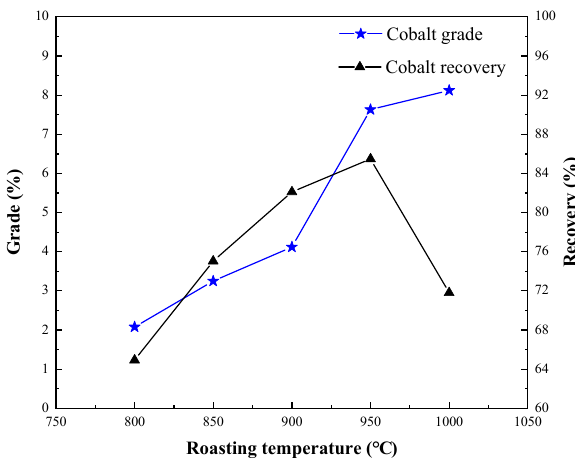
Figure 8. E ff ect of segregation roasting temperature on cobalt extraction. Figure 8. Effect of segregation roasting temperature on cobalt extraction.